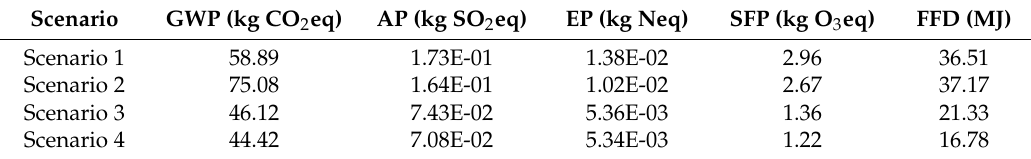
Table 8. Comparison of the GWP, AP, EP, SFP, and FFD all three studied scenarios’